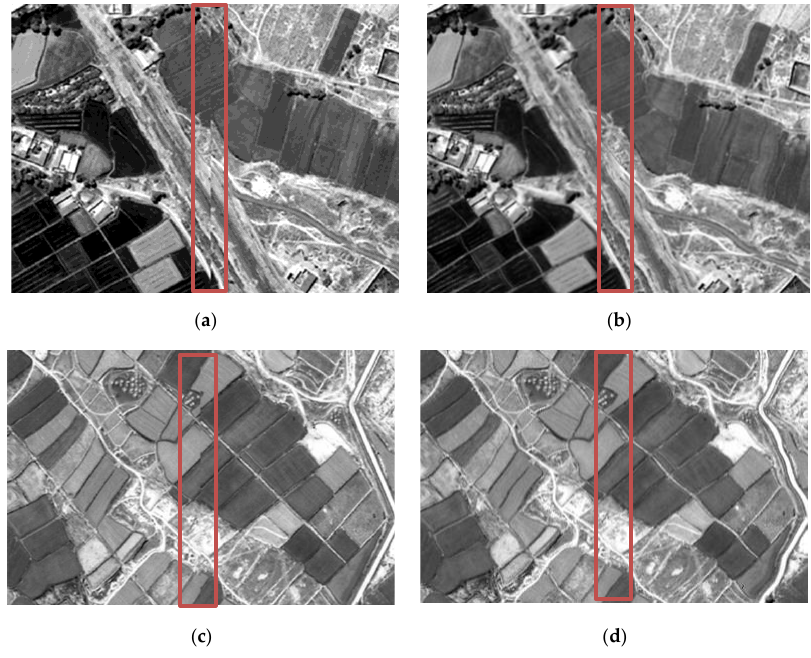
Figure 9. Experimental results in stable flight: ( a ) original and ( b ) updated overlapping area 1 of left-middle images; ( c ) original and ( d ) updated overlapping area 2 of right-middle images. The red rectangular frames the seamline between two adjacent images before and after stitching.